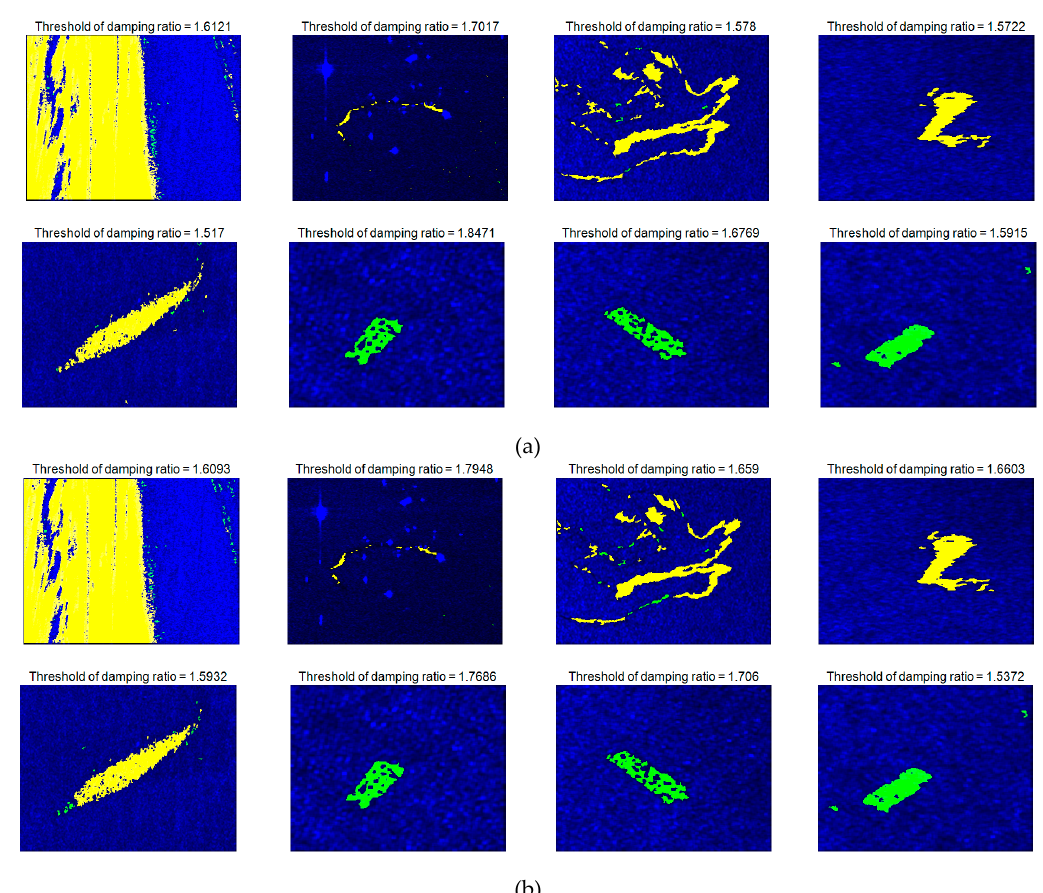
Figure 9. An example of an oil spill and the OLA detection results. The pseudo-color composite image is fused by R = Detection of oil slicks, G = Detection of dark features, and B = Span image. ( a ) The left circular mode; ( b ) the linear π /4